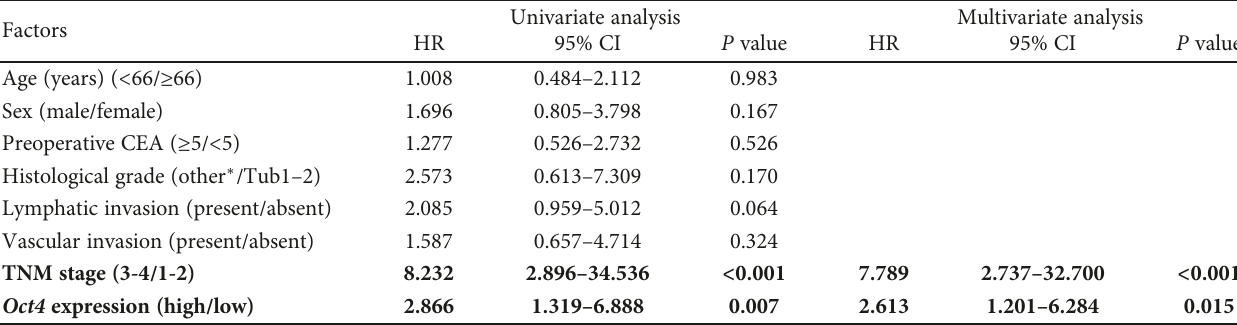
Table 3: Results of univariate and multivariate analyses of liver metastasis-free survival.